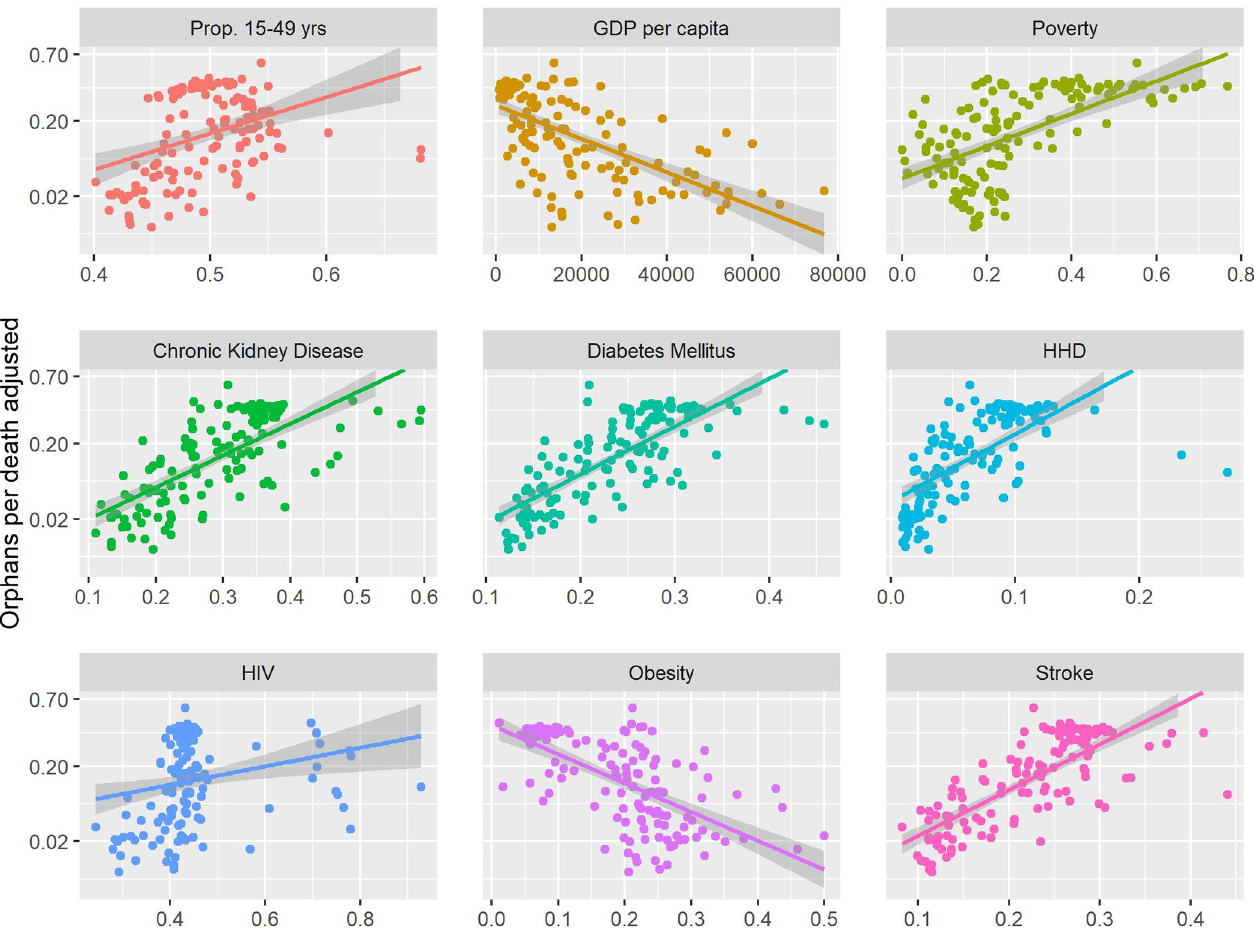
Fig 3. Simple univariate linear regression models for the correlation between covariates and OPD Adjusted (OPD divided by fertility rate). x-axis expressed as proportion (between 0 and 1) except for GDP per capita (expressed as $US). P-values calculated for regression model. Y-axis transformed to the logit scale. Note that the y-axis intervals are not evenly spaced. Orphans per death adjusted = orphans per death divided by national average total fertility rate. Solid lines represent regression prediction, grey bands represent 95% confidence interval. Chronic Kidney Disease, Diabetes Mellitus, HHD, HIV, and stroke measured as proportion of country population with condition that are aged 15–49 years. Obesity and poverty measured as proportion of population. GDP per capita measured as $US.